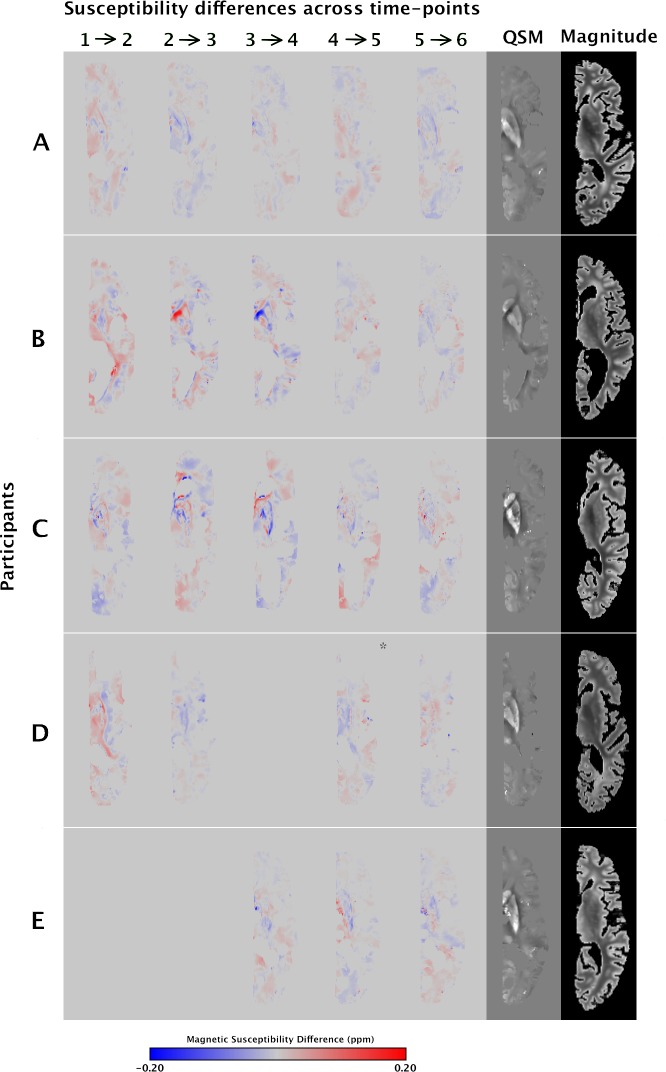
Voxel-wise differences in magnetic susceptibility maps of consecutive time-points.Ex-vivo magnetic susceptibility difference maps between consecutive time-points, for all hemispheres of Dataset 1. The corresponding susceptibility map and spin-echo image of the last time-point are displayed on the rightmost two columns. Note: For hemisphere D, the difference map marked with an asterisk represents the difference between the third and fifth time-points.